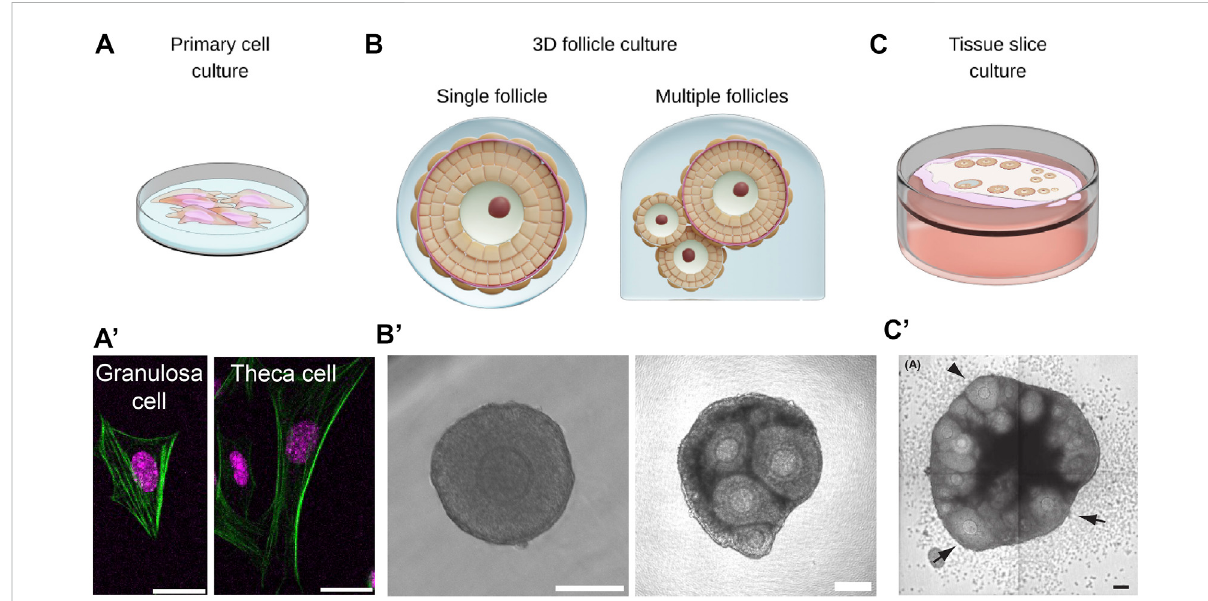
FIGURE 4 Multiscale exvivo reconstitutionapproachesarerequiredforintegrativeunderstandingofovarianmechanobiology.( A,A ’ ) .Primarycellssuchas the theca cells and the granulosa cells can be isolated from bulk ovaries for studying single cell mechanics or cell-cell interactions in co-culture systems. Scale bar: 20 μ m. (B,B ’ ) . Isolated follicles can be cultured in 3D hydrogel for studying morphogenesis and the impact of mechanical con fi nementonfolliclegrowth.Aggregates offolliclescanalsobeculturedin3Dtostudyfollicle-follicleinteractions. Scalebar:100 μ m. (C,C ’ ) . Ovarian tissue slices can be cultured ex vivo to study collective dynamics of follicles and ovulation during development. Scale bar: 100 μ m. Image from (Komatsu and Masubuchi,